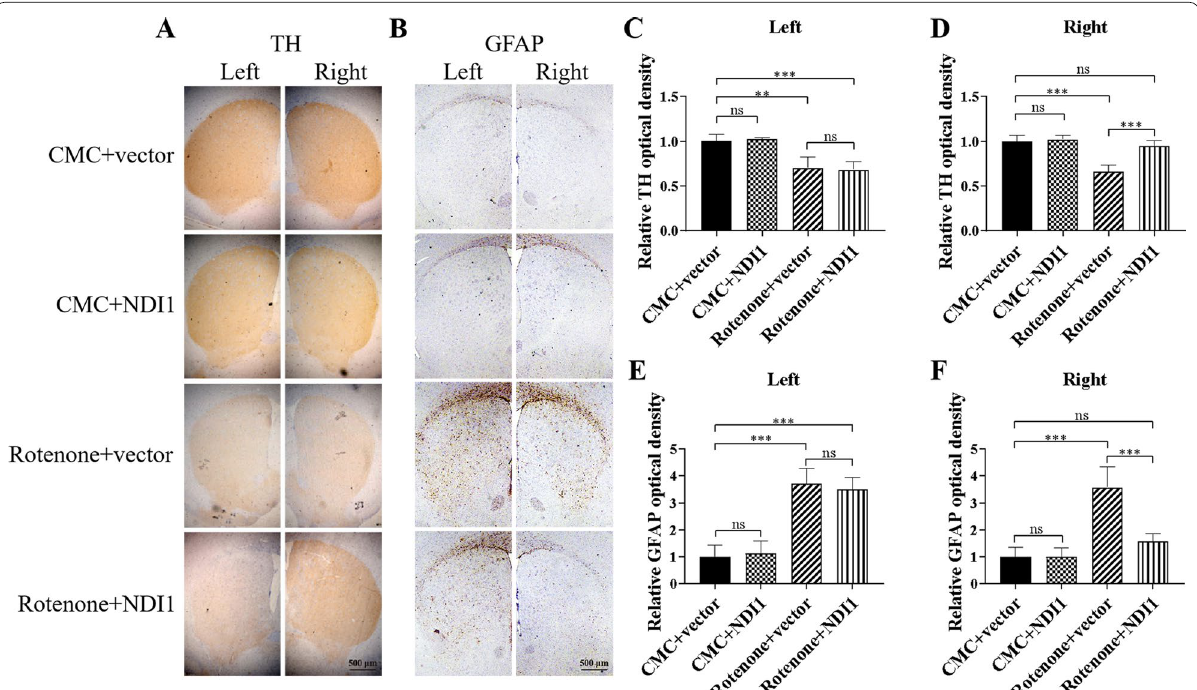
Fig. 8 The content of TH and GFAP in striatum of rotenone-induced PD mouse model transduced with NDI1. A TH content in stratum (i.e. the content of dopamine) was examined by immunohistochemistry. The striatum sections were stained with TH antibody (brown). Scale bar 500 μm. = B GFAP (glial fibrillary acidic protein) content in stratum was examined by immunohistochemistry. The striatum sections were stained with GFAP antibody (brown). Scale bar 500 μm. C , D TH (tyrosine hydroxylase) staining intensity was quantified by ImageJ software. The TH-positive optical = density values in the left and right striatum were subjected to statistical analysis. E , F GFAP staining intensity was quantified by ImageJ software. The GFAP-positive optical density values in the left and right striatum were subjected to statistical analysis. Rotenone vector group compared + with DMSO vector group, or Rotenone NDI1 group compared with Rotenone vector group, or Rotenone NDI1 group compared with + + + + DMSO vector group, ns not significant, ** P < 0.01, *** P < +